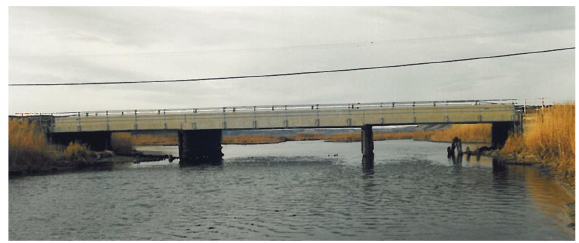
Figure 1: Photograph of the bridge prior to girder